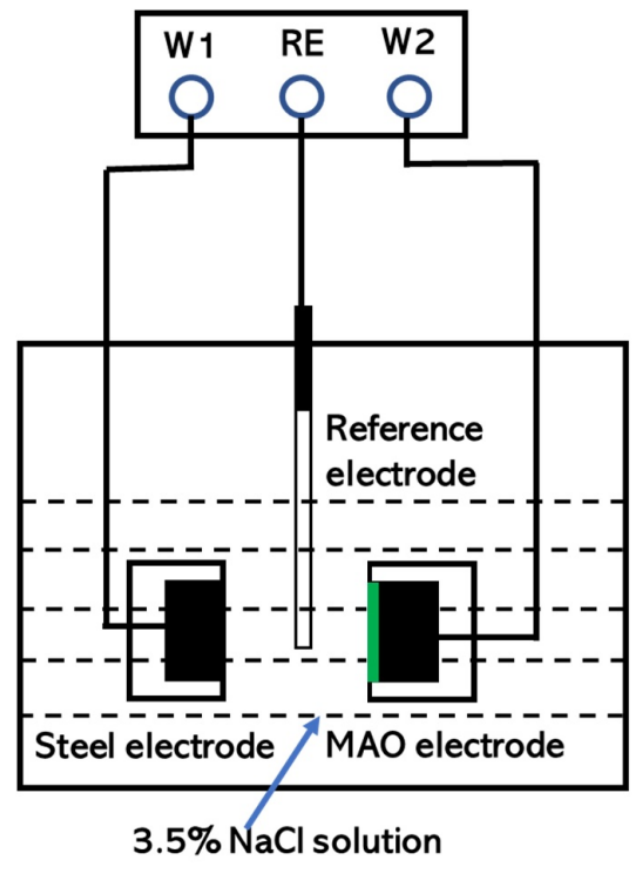
Figure 1. Schematic diagram of galvanic corrosion measurement between micro-arc oxidation (MAO) electrodes and steel electrode.